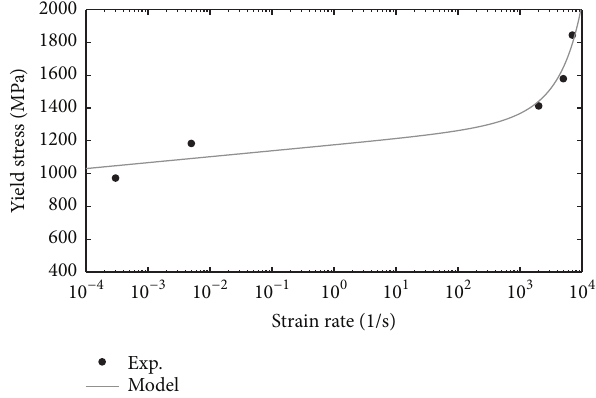
Figure 4: Comparison between experimental data (Subhash et al. [36]) and new modified Eyring equation for CVD textured ⟨011⟩ tungsten.